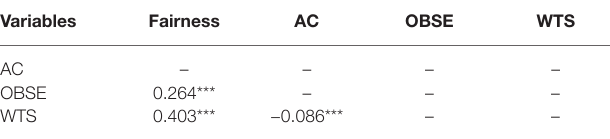
TABLE 3 | Standardised indirect